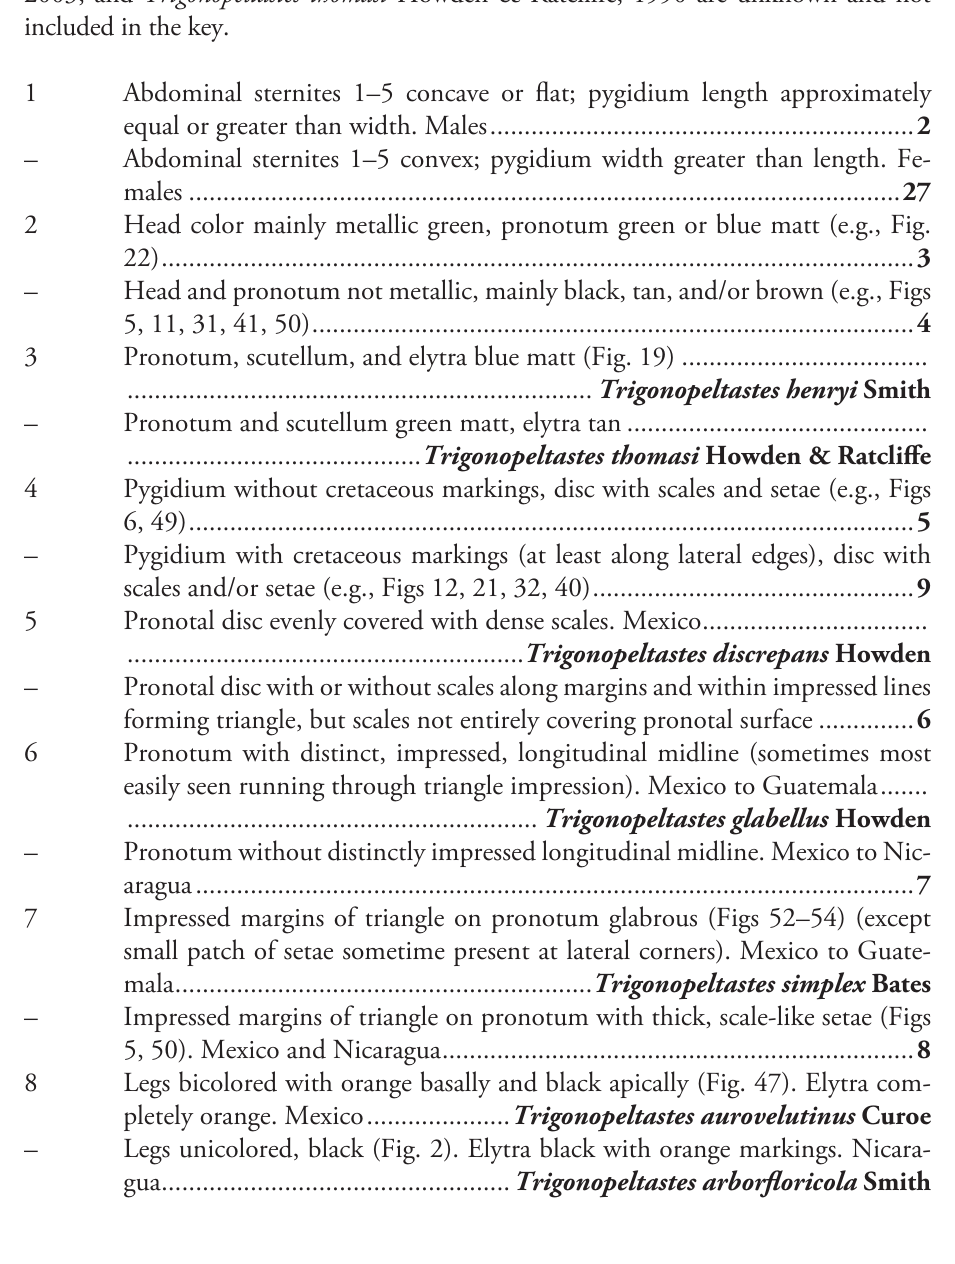
Pygidium with cretaceous markings (at least along lateral edges), disc with